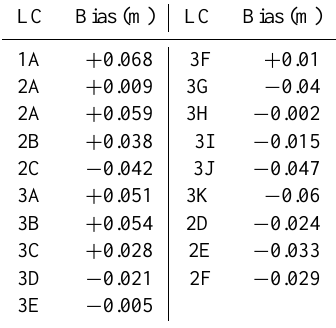
Table 1. ICESat inter-campaign offset (LC) determined in Ewert et al. (2012a) updated for release